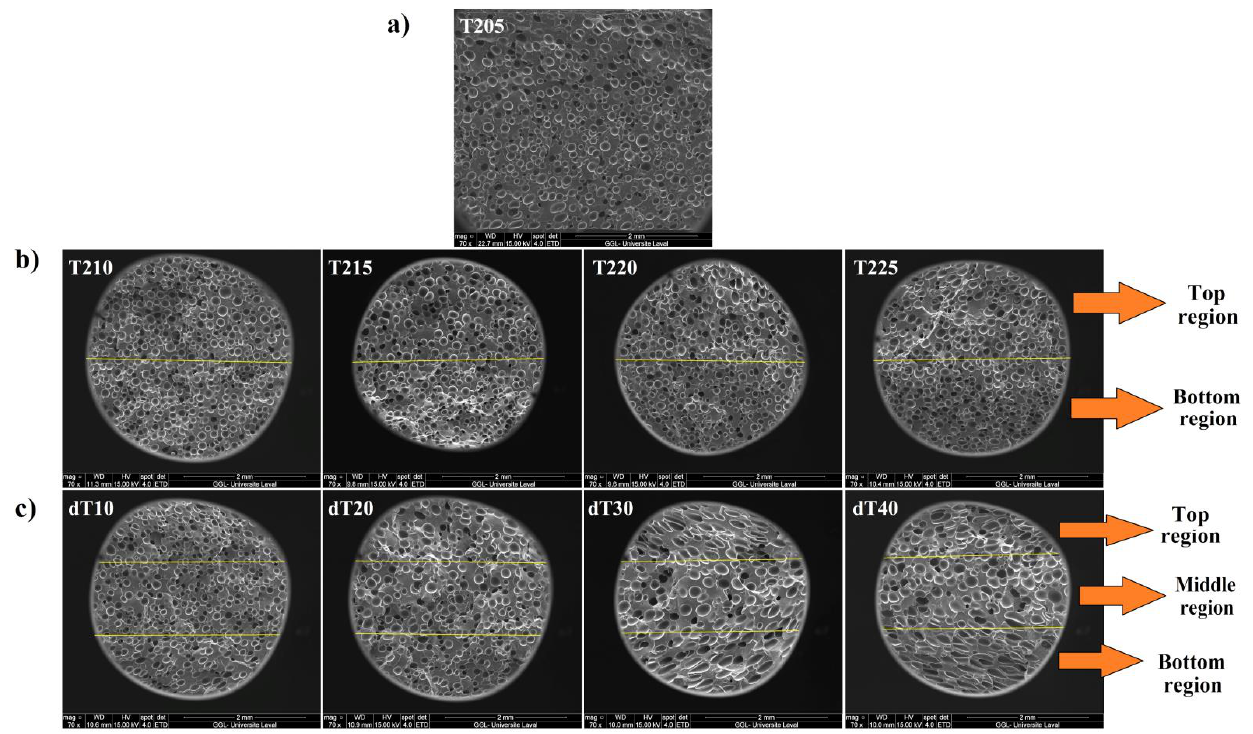
Figure 1. ( a ) SEM images of the uniform foam (T205) and graded POE foams: ( b ) first series and ( c ) second series (scale bar of 2 mm).